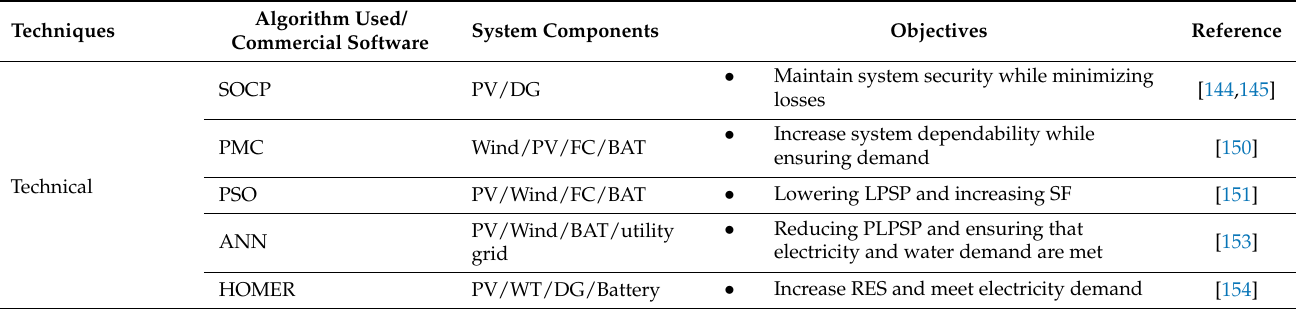
Table 12. Management methods